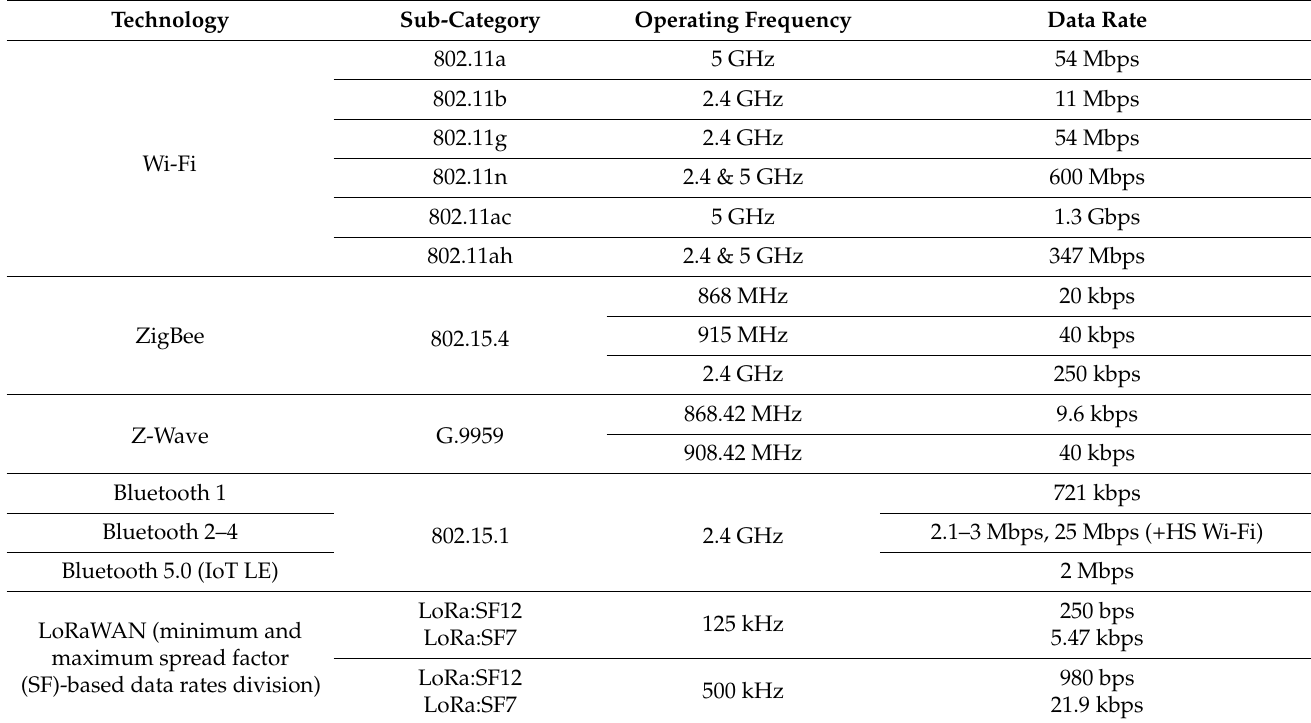
Table 2. IoT technologies comparison with respect to their data rates.